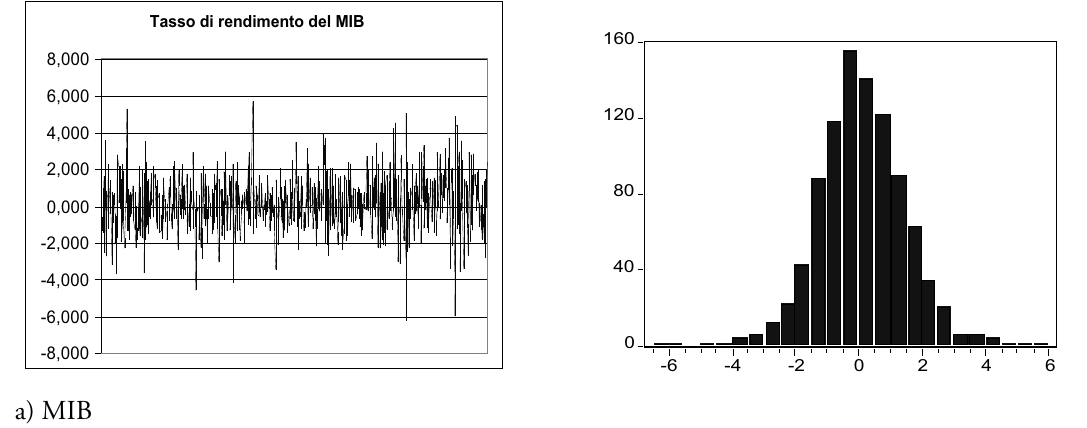
Figure 3 – Time series of the MIB Index (series a) and of the returns of the various assets classified within 6 categories (series b to g) in the time period ranging from the 14th October 1994 to the 18th August 1998.